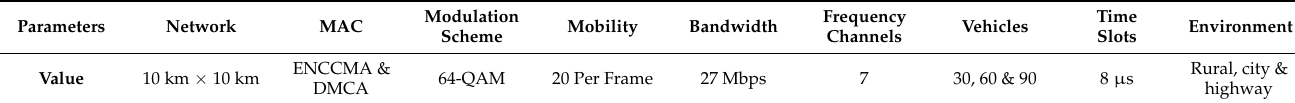
Table 2. Evaluation Simulation Parameters.